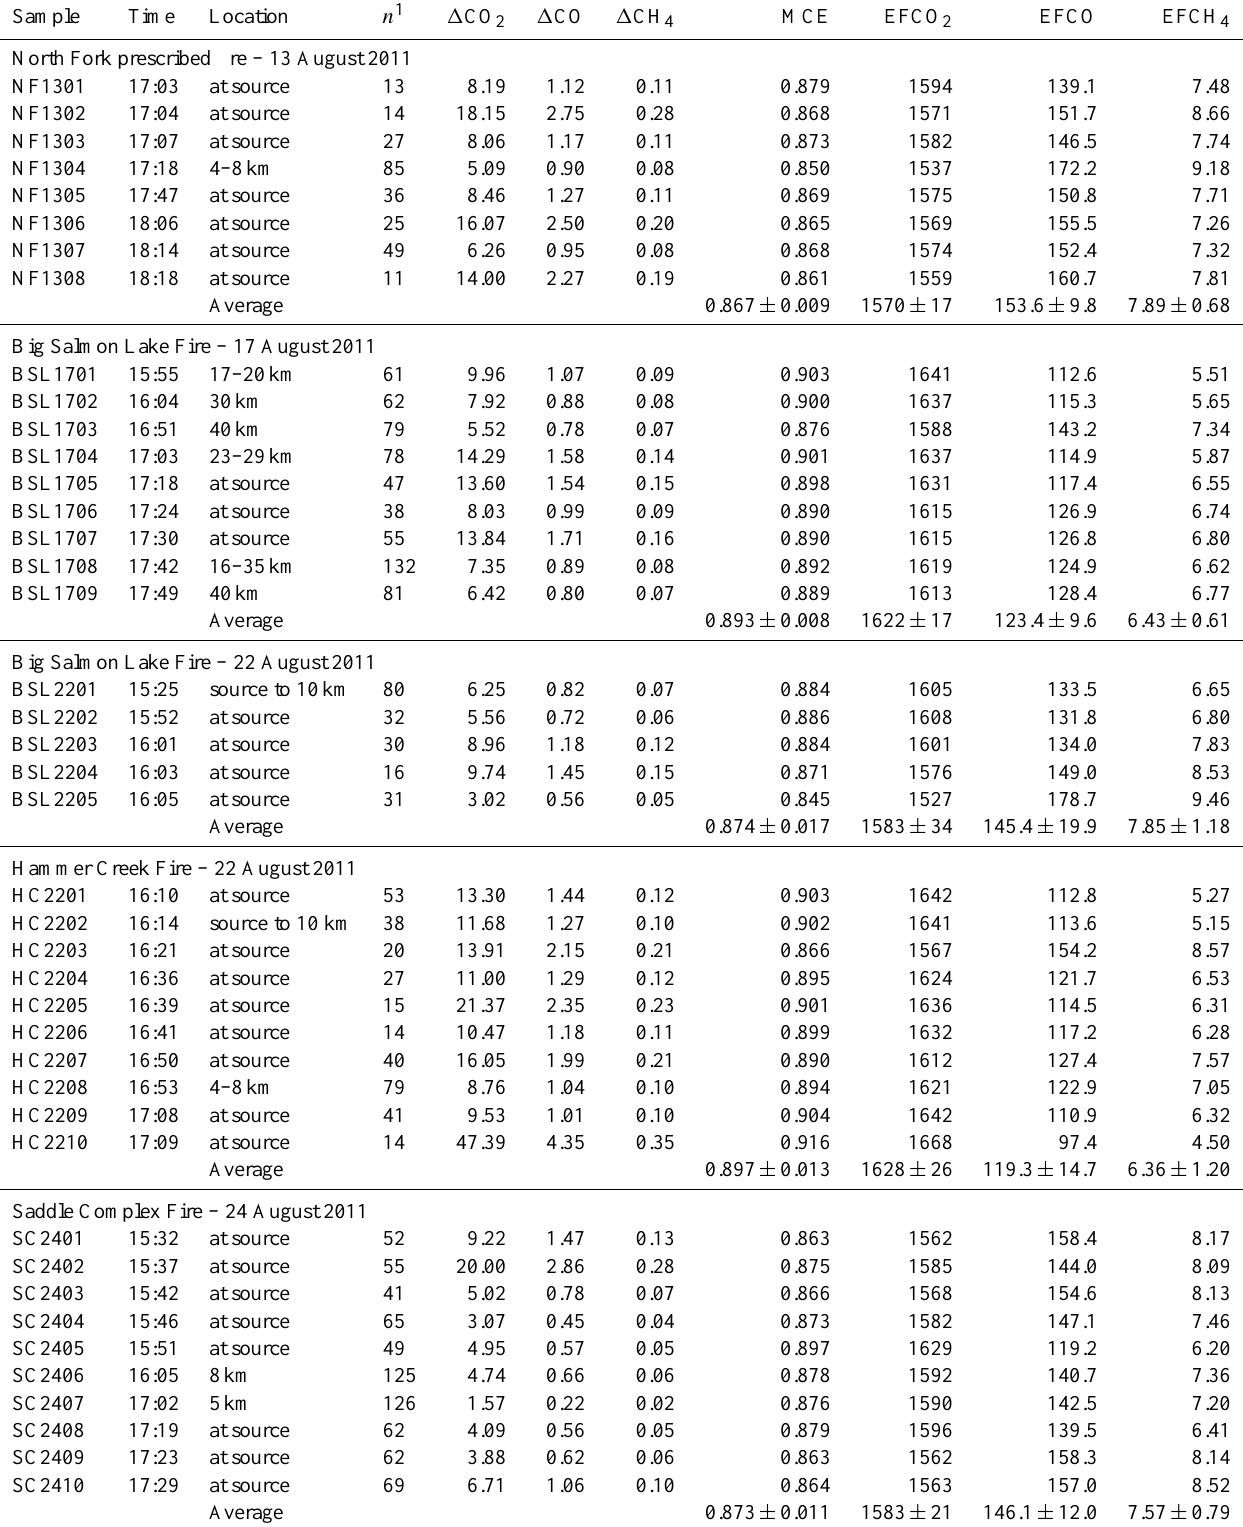
Table 2. Smoke sample EMR, MCE, and EF and fire–day average ( ± 1 standard deviation) MCE, EF, and EMR. EMR are sample average or fire-day average of the individual 2s data points. EMR are in units of ppmv. EF are in units of gkg − 1